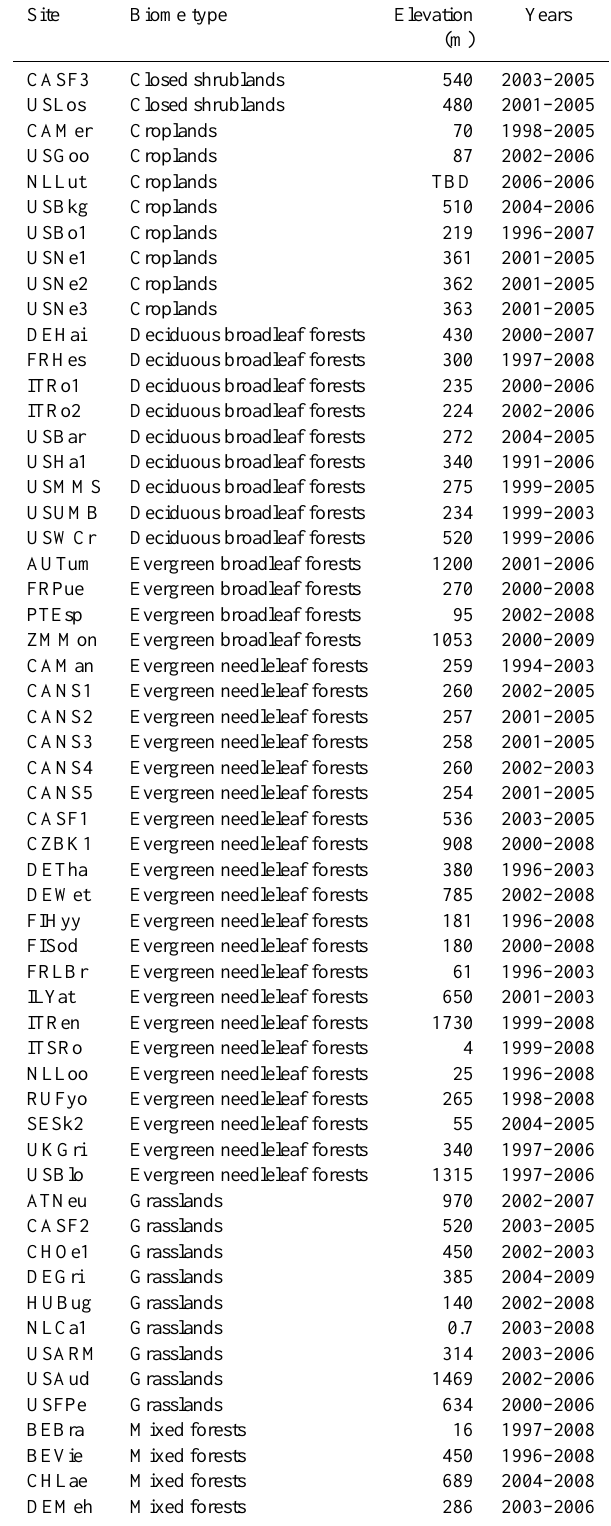
Table 1. Summary of the FLUXNET sites used in this study. More site information can be found at